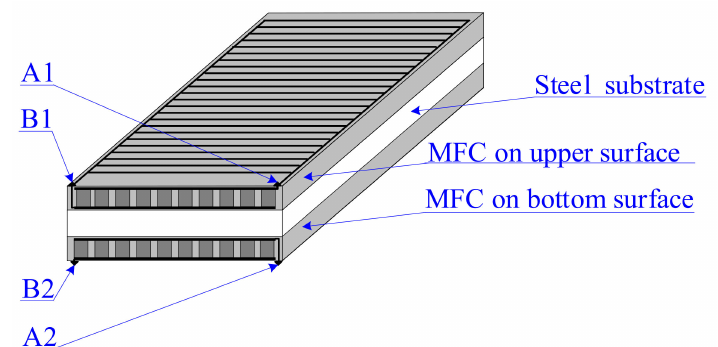
Figure 8. Conduit connections in MFC